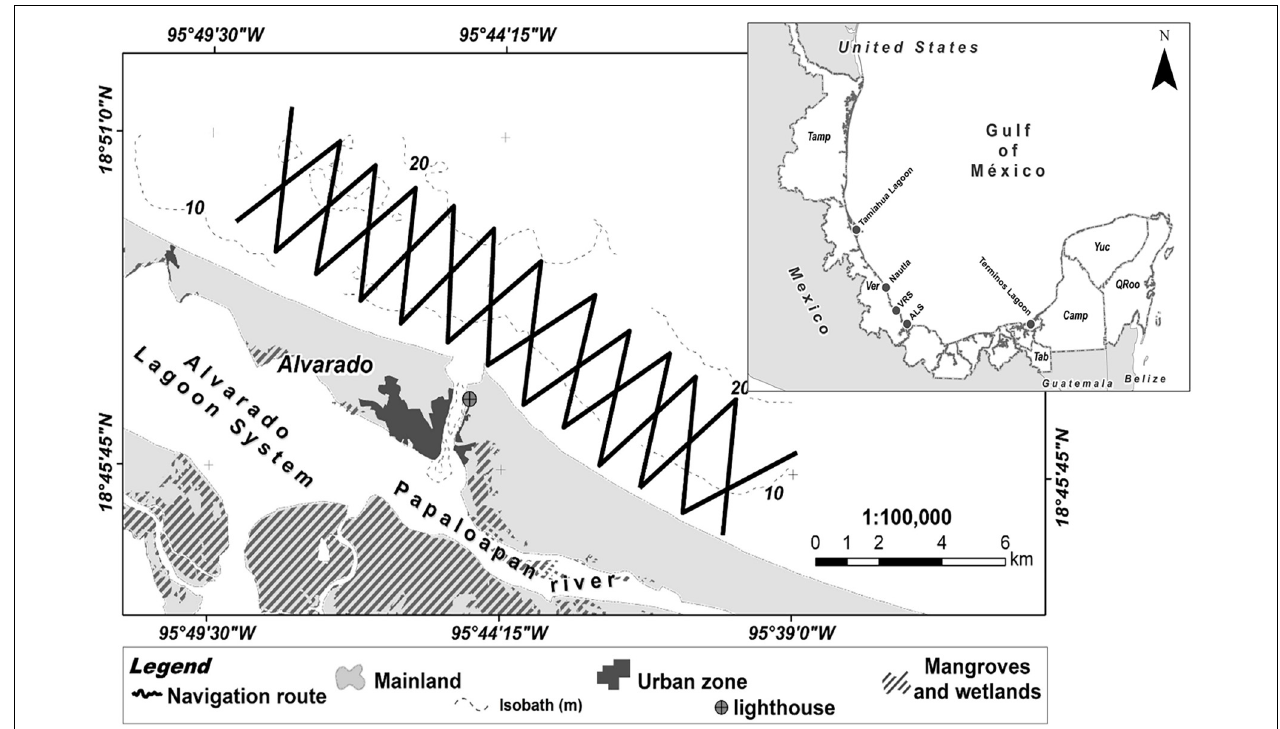
FIGURE 1 | Location of the study area. ALS = Alvarado Lagoon System, Tam = Tamaulipas, Ver = Veracruz, Tab = Tabasco, Cam = Campeche, Yuc = Yucatán, QRoo = Quintana Roo. Nearby locations with studies on bottlenose dolphins are also shown (e.g., Tamiahua Lagoon, Nautla, VRS = Veracrus Reef System National Park). Zigzag lines indicate line transect